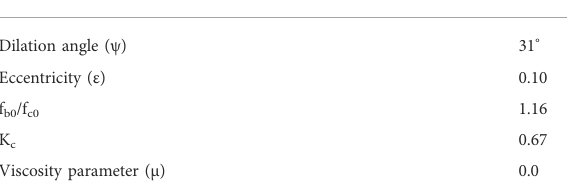
TABLE 1 Default parameters for the CDP concrete model, taken from Ahmadi et al. (2022), Anas et al. (2022J), Anas et al. (2022K), Anas et al. (2022L), Anas et al. (2022M), Anas et al. (2022N), Anas et al. (2022O),Shariqetal.(2022b),Shariq etal.(2022c), andAnasand Alam